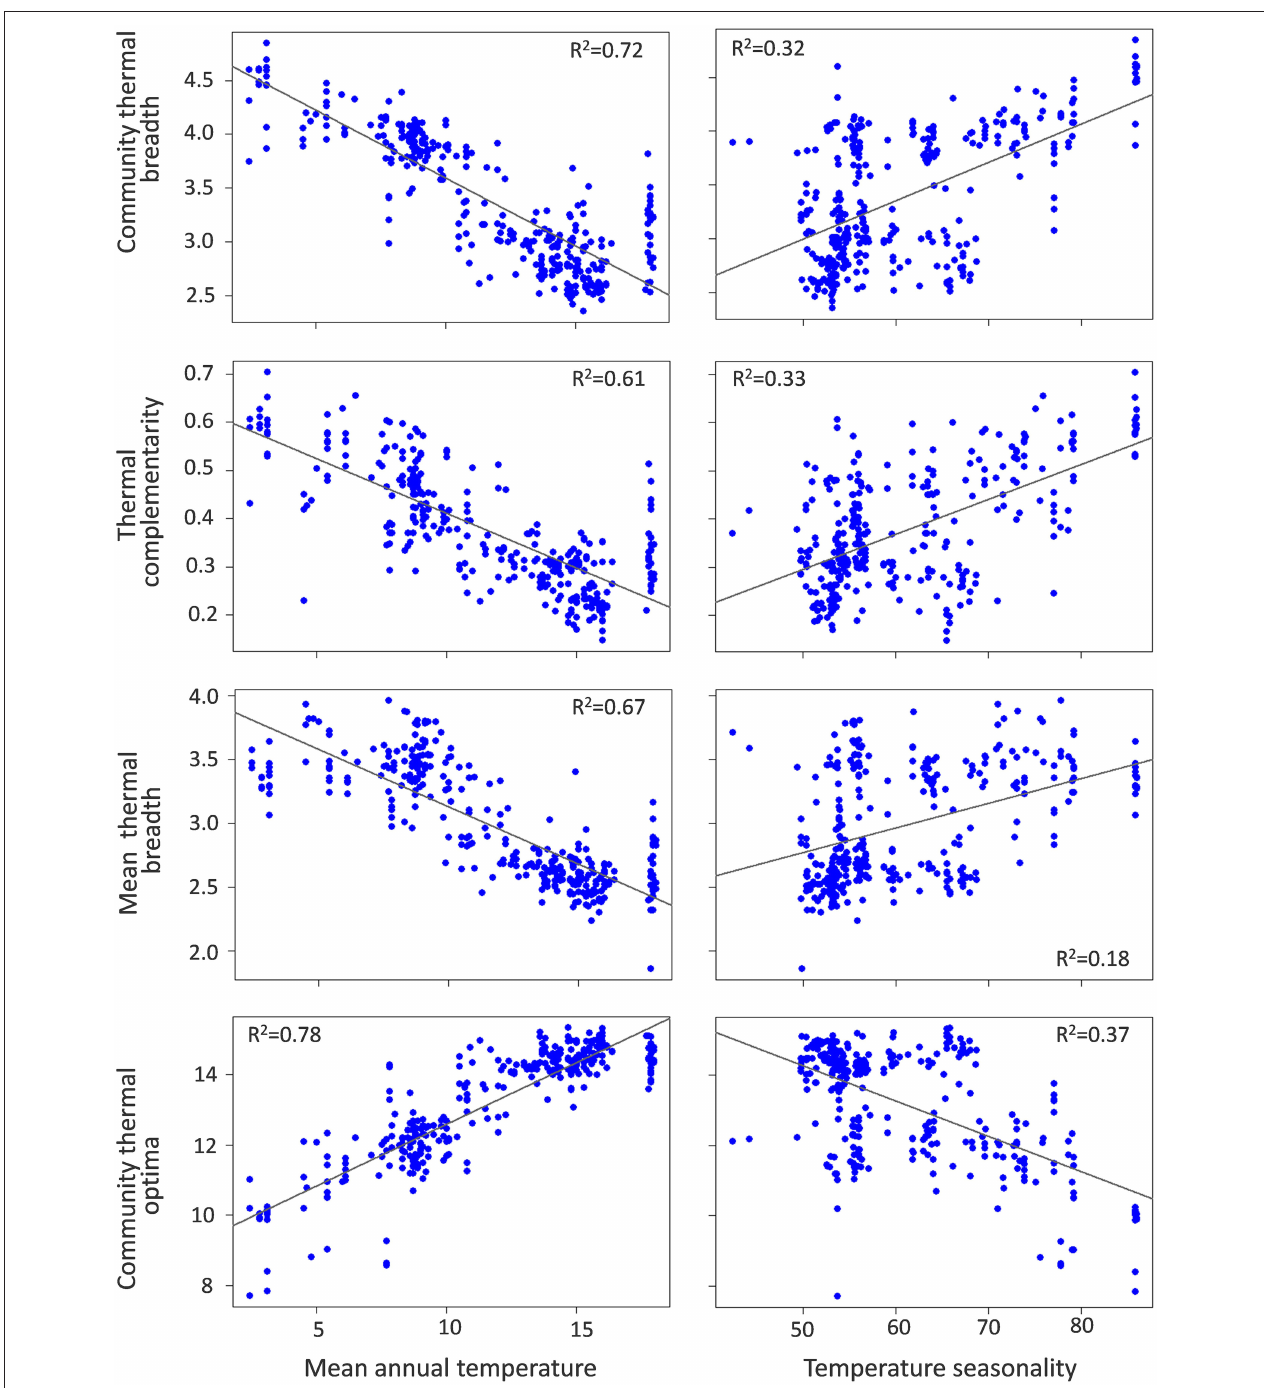
FIGURE 3 | Relationships of community thermal breadth, thermal complementarity (arcsin transformed), and mean thermal breadth with mean annual temperature (MAT, ◦ C) and temperature seasonality (TS, standard deviation of MAT).